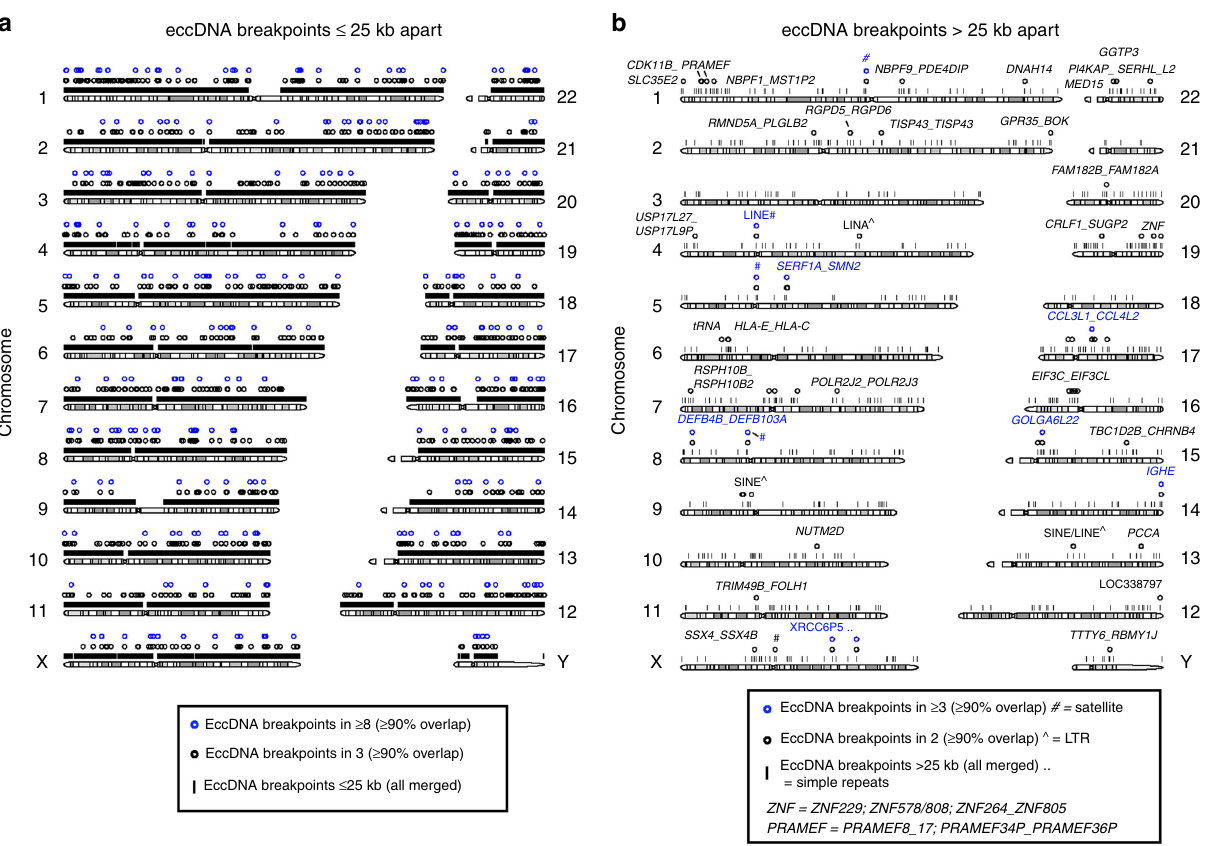
Fig. 3 Genomic distribution of eccDNA breakpoints. Distribution of detected chromosomal breakpoints across the human genome with read support for circular DNA, in sizes of a ≤ 25 kb (total 147,186) and b >25 kb apart (total 1,014) in muscle (T1 – T16, n = 16) and leukocyte (B1 – B16, n = 16) samples. EccDNA detected once, black lines; eccDNA detected repeatedly in several individuals with ≥ 90% overlap, Deletions correspond to eccDNA . The discovery of [ ERBB2 circle exon 1-7 ] and other eccDNAs with parts of genes suggested that